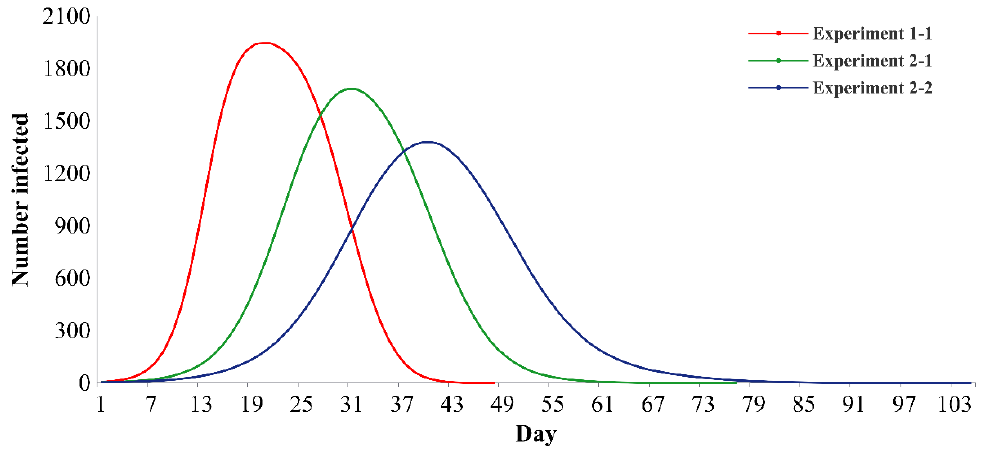
Figure 4. Infection curves of different intensities of the RGOUT policy (the other policies are loose).